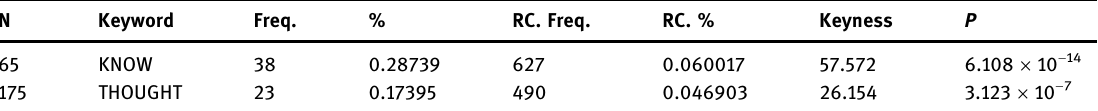
Table 5: Mental processes in the keyword